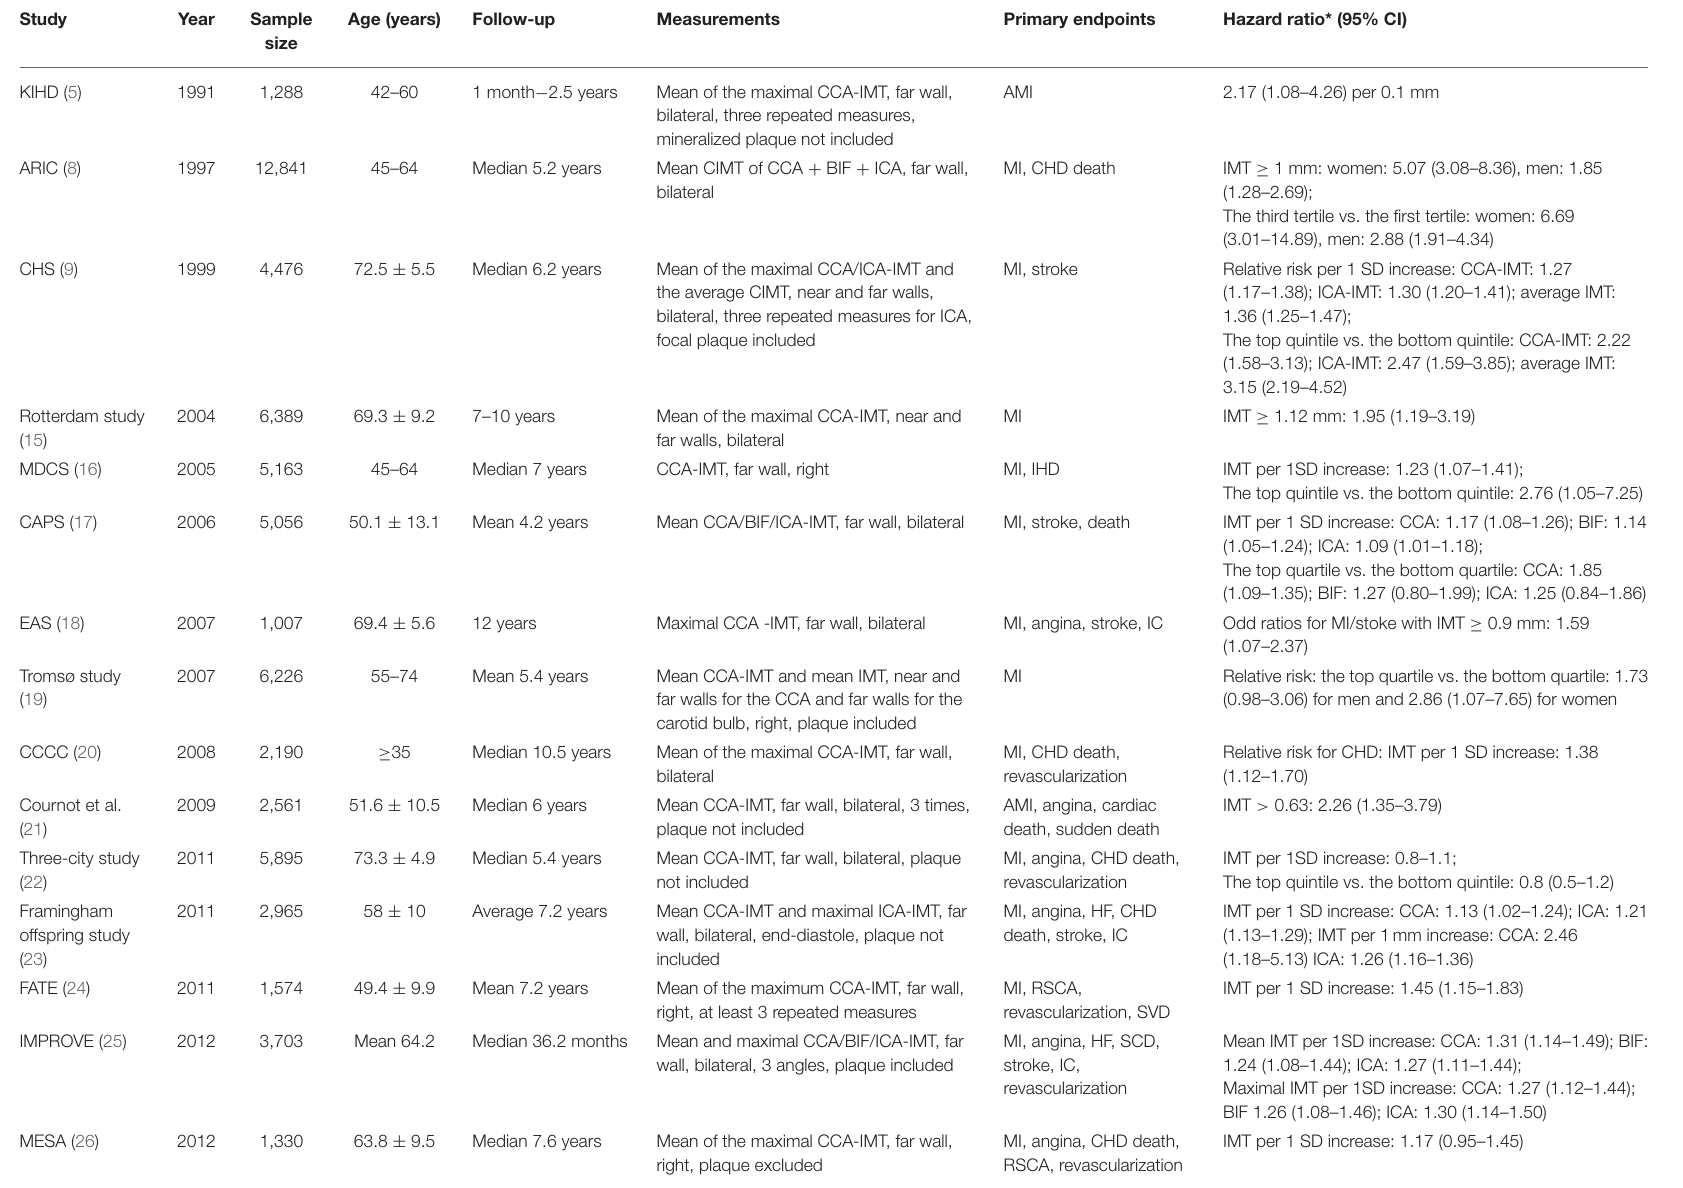
TABLE 1 | Prospective studies with a large general population that assessed the association between carotid intima-media thickness (CIMT) and cardiovascular risk.